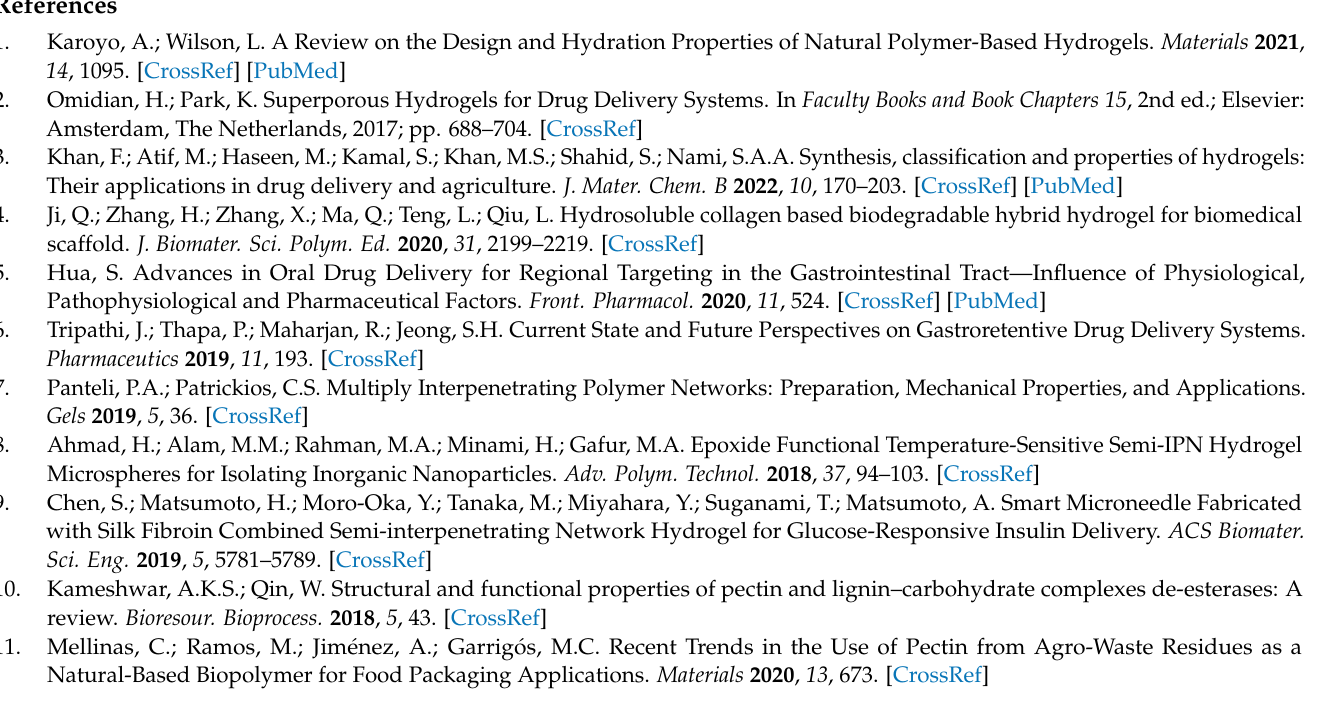
explanation for the probable synthesis of the SPHHs; Figure S2: Schematic representation of the synthesis procedure of a semi-IPN for SPHHs; Figure S3: Schematic representation of the drying of super-porous hybrid hydrogels comprising dehydration, filtration, and drying procedures; Figure S4: Schematic design of the drug-loading process of SPHHs-AT absorption and drying; Figure S5: Super- porous hybrid hydrogel synthesis procedure steps; Figure S6: Overlay diagram of (a) FTIR spectra of SPHHs-AT-3 and AT; (b) DSC thermograms of AT, SPHHs, and SPHHs-AT-3; (c) X-ray diffraction of AT and SPHHs-AT-3; Figure S7: Calibration curve; absorbance values of AT were measured at a λ max of 272 nm; Figure S8: UV spectrum of (a) water; (b) amoxicillin trihydrate (AT); (c) SPHHs-AT with pH 1.2; (d) SPHHs-AT with pH 7.4; Table S1: Synthesis of semi-IPN super-porous hybrid hydrogels (SPHHs) † of amoxicillin trihydrate (AT); Table S2: pH-dependent swelling appearance of SPHHs-AT; Table S3: Experimental data for gastroretentive SPHHs formulations. References [2,3,31,49,59–67] are cited in the Supplementary